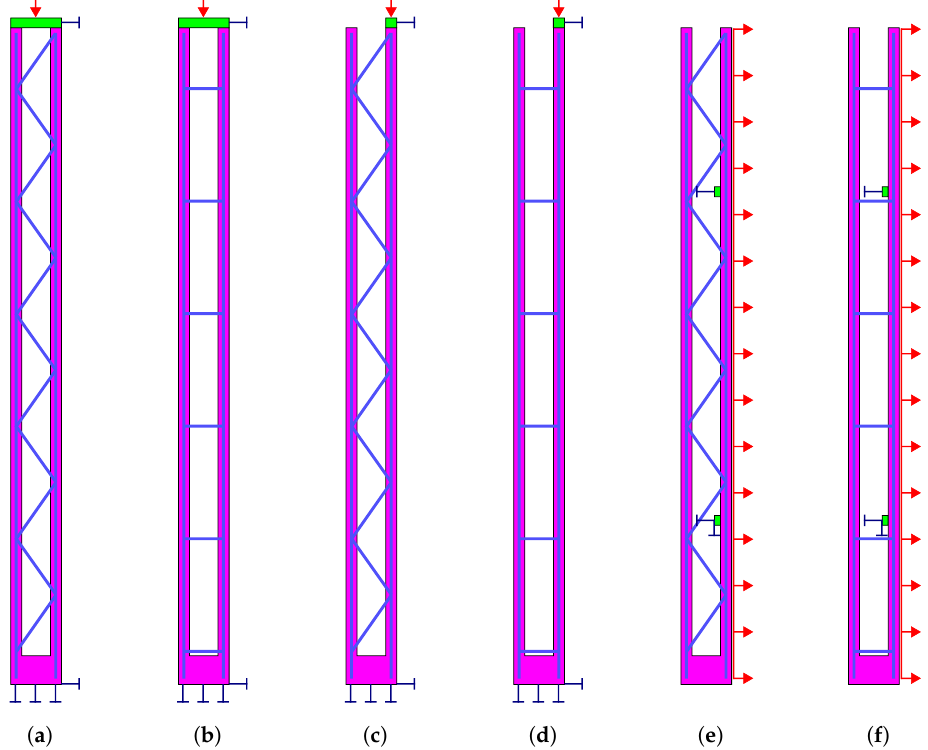
Figure 7. Models of sandwich walls (SWs) used in the structural analysis: ( a ) composite and ( b ) non- composite SWs under centric loading; ( c ) composite and ( d ) non-composite SW under eccentric loading; and ( e ) composite and ( f ) non-composite SW in demoulding stage; see legends in Figure